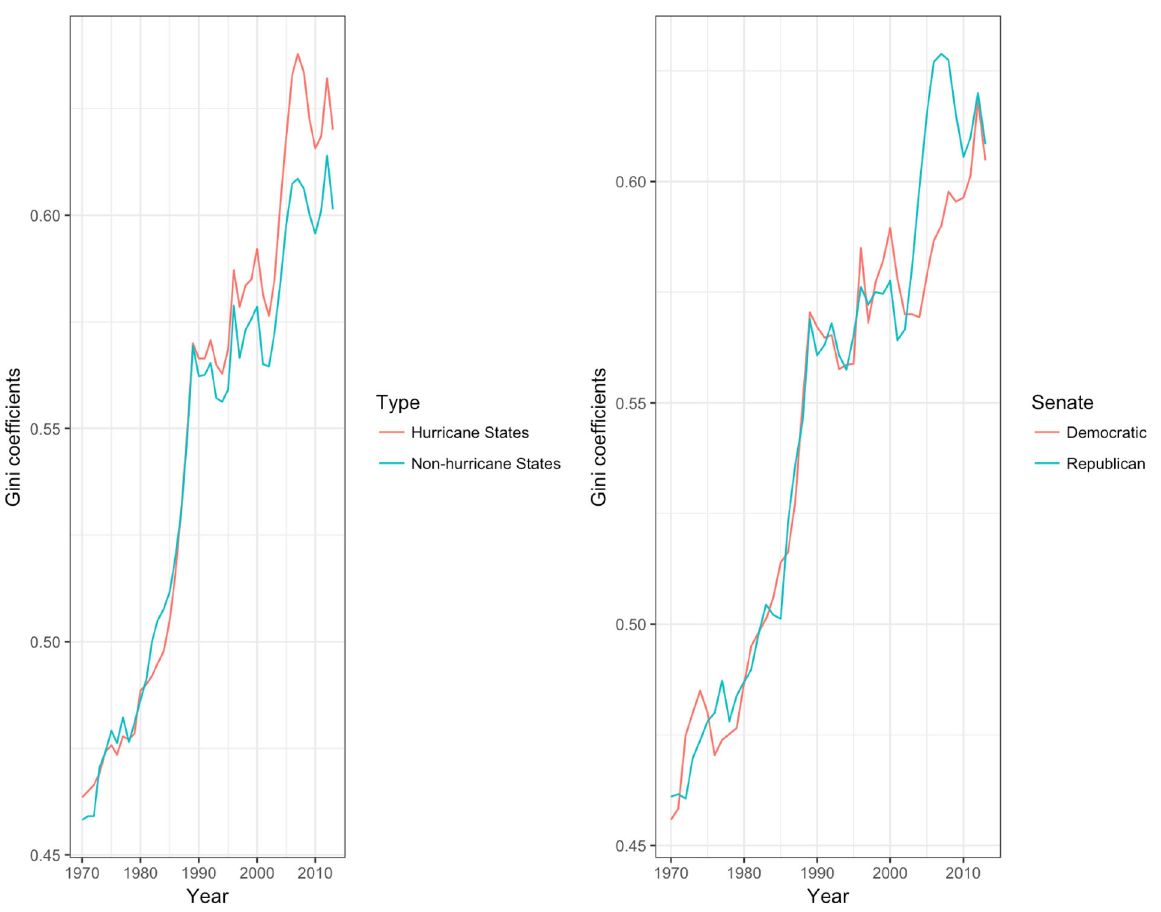
Fig. 2 Average Gini coefficients in the United States for the period 1970–2013, for hurricane versus non-hurricane states (left), and depending on a Democratic versus a Republican Senate (right).